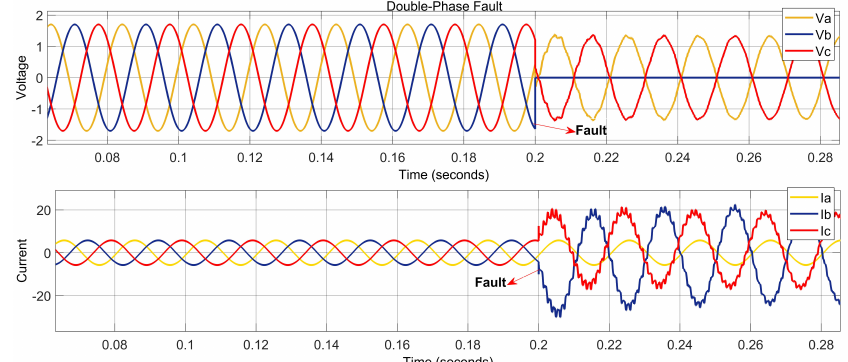
Figure 6. Double-phase to ground fault